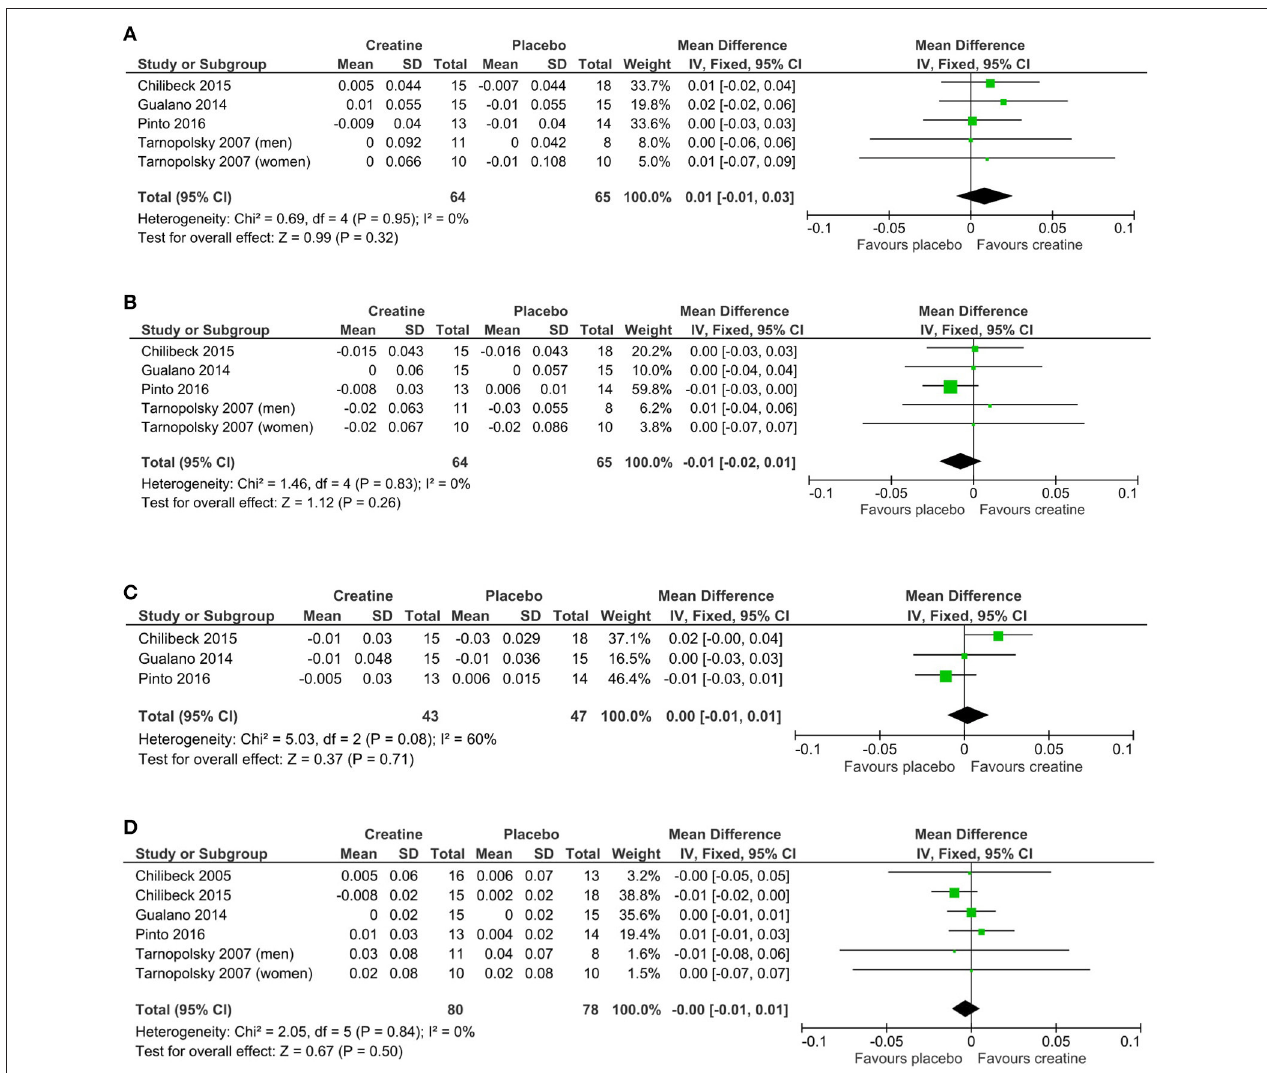
FIGURE 3 | Meta-analyses of creatine and resistance training studies on (A) lumbar spine, (B) hip, (C) femoral neck, and (D) whole body bone mineral